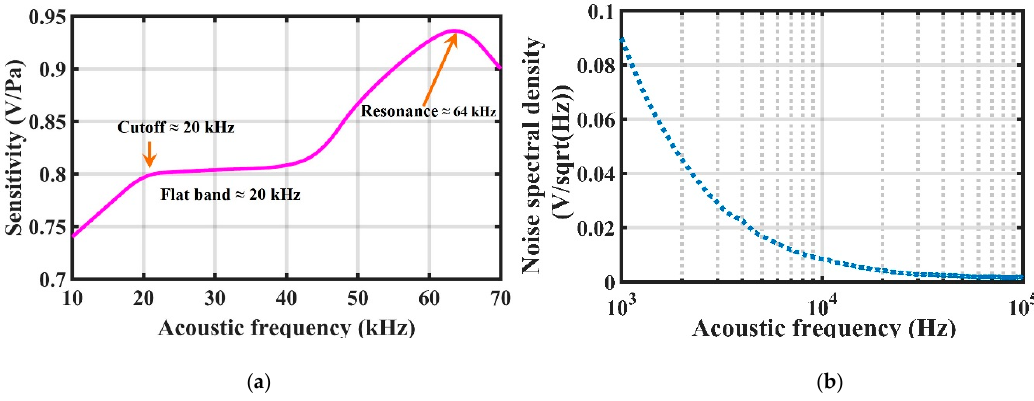
Figure 11. ( a ) Sensitivity of the sensor versus acoustic frequency; ( b ) Noise spectral density of the sensor.